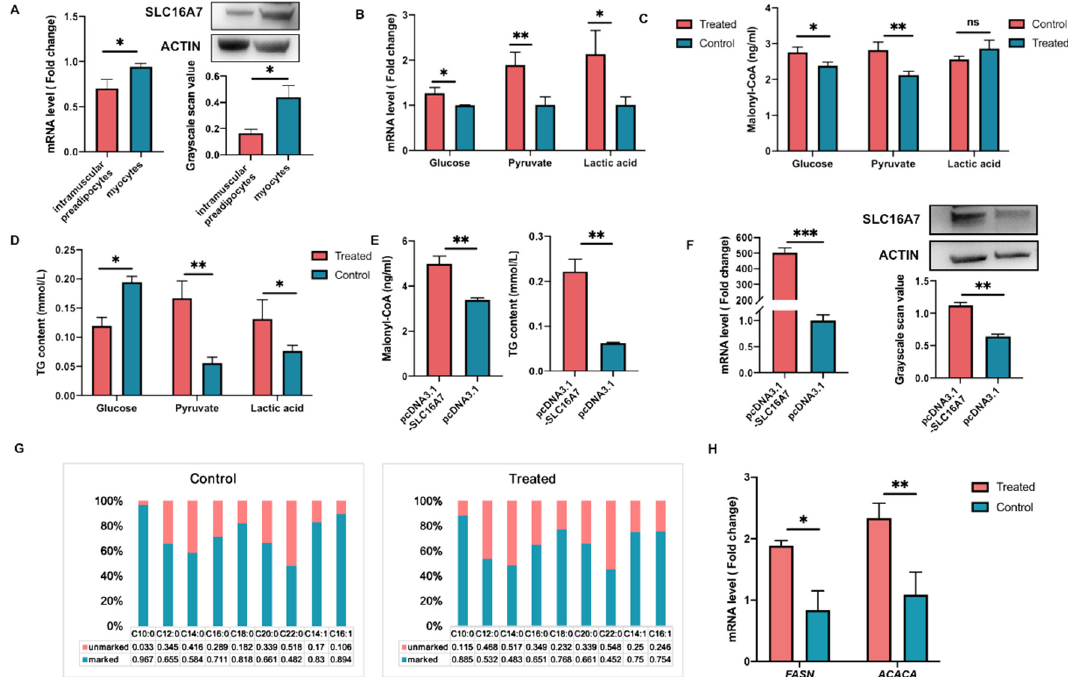
Figure 4. In vivo regulatory effect of SLC16A7 on TG synthesis via de novo lipogenesis. ( A ) The expression of the SLC16A7 gene in intramuscular preadipocytes and myocytes, mRNA expression level (left) and protein expression level (right). Error bars represent SEM (* p < 0.05). ( B ) SLC16A7 mRNA Expression level (* p < 0.05, ** p < 0.01). ( C ) The content of malonyl-CoA after exogenous addition of Glucose, pyruvate and sodium lactate were added externally for 48 h (* p < 0.05, ** p < 0.01, ns: not significant). ( D ) The content of TG after exogenous addition of Glucose, pyruvate and sodium lactate were added externally for 48 h (* p < 0.05, ** p < 0.01). ( E – H ) The high transfection efficiency of the overexpression vector of SLC16A7 gene, ( E ) the contents of TG and malonyl-CoA in myocytes (** p < 0.01), ( F ) The expression of the SLC16A7 mRNA (** p < 0.01, *** p < 0.001), ( G ) Relative propor- tions of 13 C isotope-labeled and unlabeled fatty acids in myocytes, ( H ) The genes expression changes related to FA biosynthesis and lipid deposition after transfection for 48 h in myocytes (* p < 0.05, ** p <